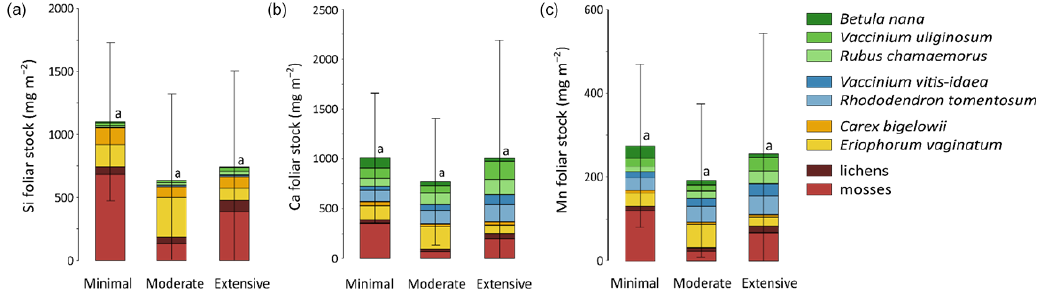
Figure 8. Cumulative stocks (mgm − 2 ) of (a) silicon, (b) calcium, and (c) manganese into foliar tissues of vascular species and tissues of non-vascular species between the different permafrost thaw areas from the thermokarst gradient (Gradient) in 2017. Vegetation is sorted by plant functional types: deciduous shrubs and forbs (green), evergreen shrubs (blue), sedges (yellow), and lichens and mosses (red). Stages of permafrost degradation are classified as Minimal, Moderate, and Extensive, based on permafrost thaw and subsidence rate. Letters correspond to a one-way ANOVA test and compare the total foliar elemental stocks between the three stages of permafrost degradation. Error bars represent standard